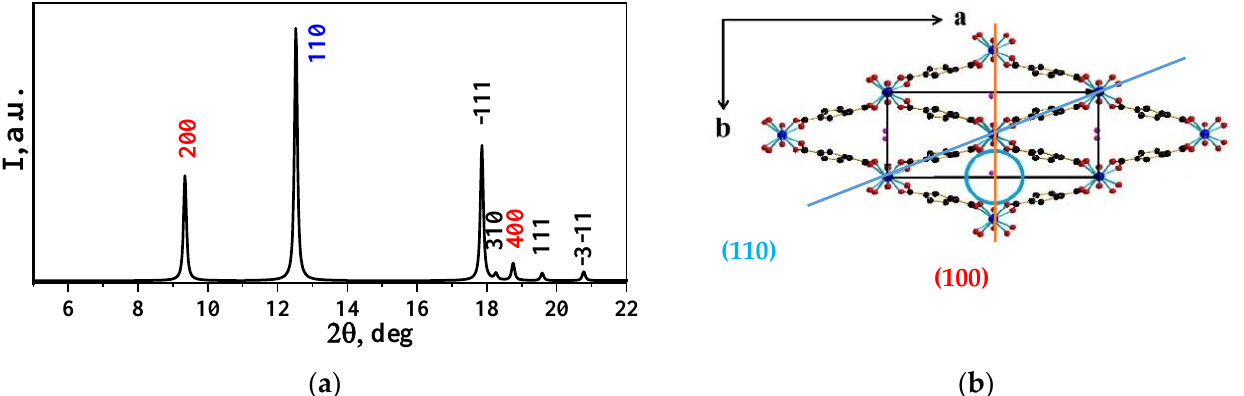
Figure 3. Structure III (sp.gr. C 1 c 1 or C 1 2/c 1; z = 4): theoretical diffraction pattern ( a ), structure projected onto the XY plane ( b ).